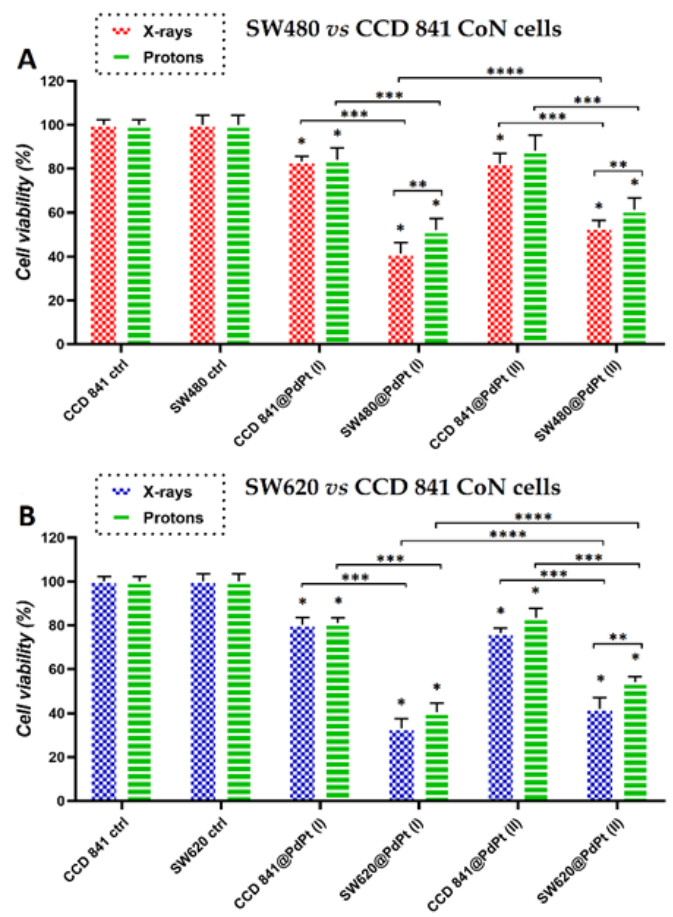
Figure 7. Viability of ( A ) SW480 and ( B ) SW620 compared to the viability of CCD 841 CoN normal colon epithelium cells after their incubation with PdPt (I) or PdPt (II) and X-ray (blue bars) or proton (green bars) irradiation with the total dose of 15 Gy. The MTS test was performed after 18 h of cell irradiation, preceded by an 18 h culture of cells with non-toxic concentrations of NPs. Data were considered significant if * p -value < 0.05 vs. control, ** p -value <0.05—statistically significant differences between PdPt NPs-assisted X-ray and proton irradiation. *** p -value < 0.05—statistically significant differences between respective cancer and normal cells, **** p -value < 0.05—statistically significant differences between the radiosensitizing effect of PdPt (I) and PdPt (II).